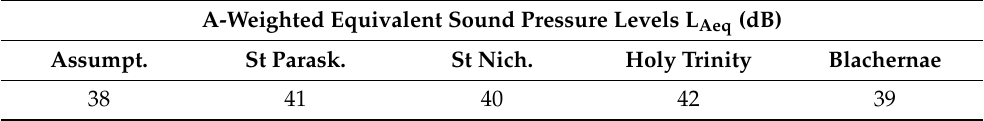
Table 2. Measured ambient noise levels of the Albanian